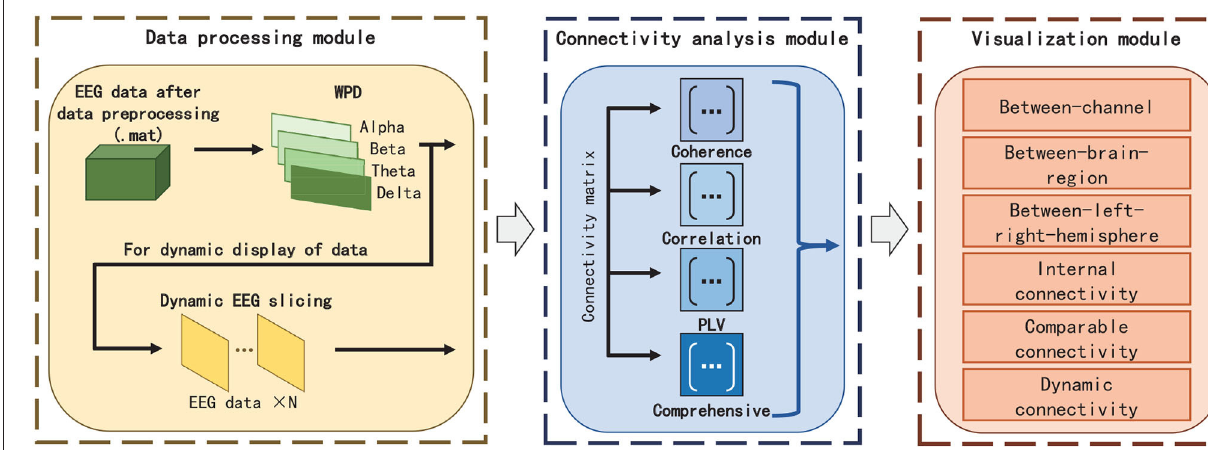
FIGURE 1 | Overall framework of EEG-FCV.